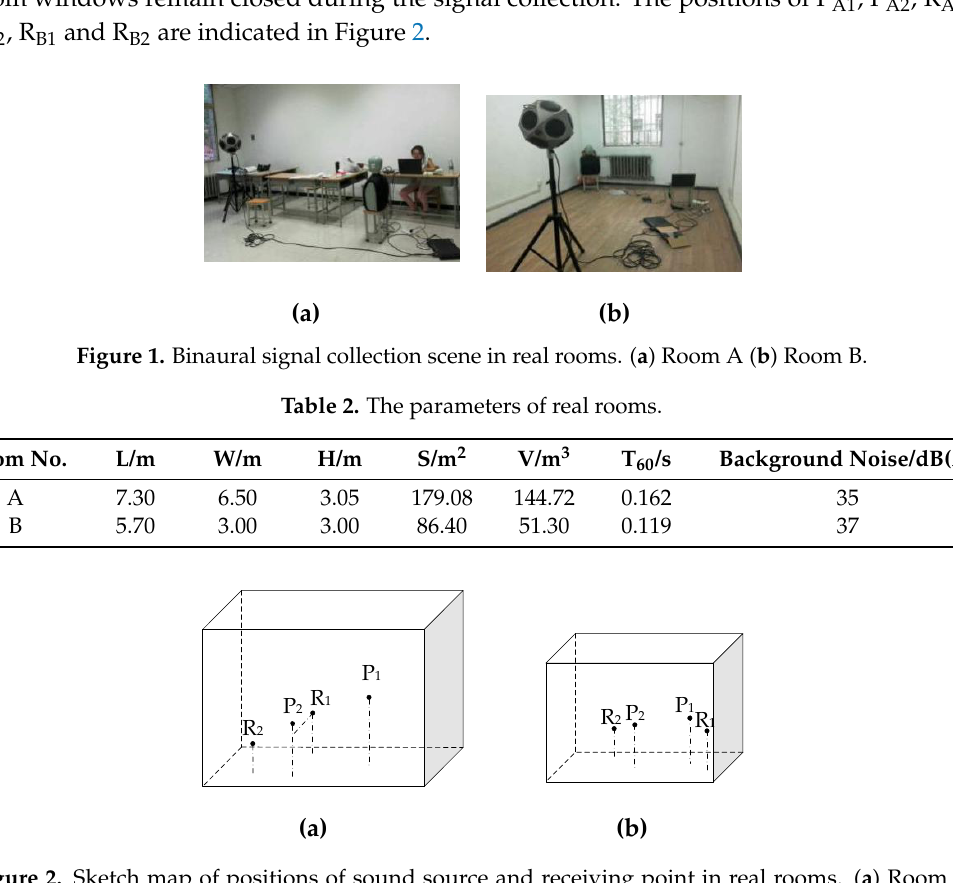
( b ) Room Figure 2. Sketch map of positions of sound source and receiving point in real rooms. ( a ) Room A